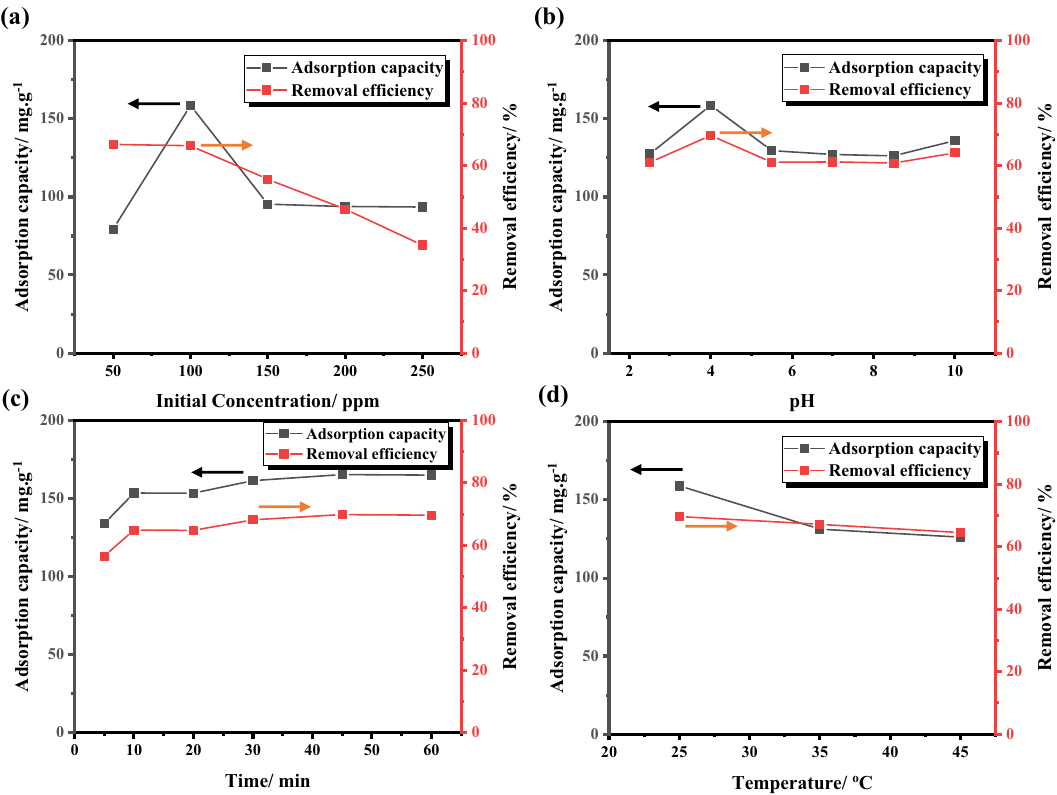
Figure 10. ( a ) Initial concentration (temperature of 25 °C, pH of 4–4.5), ( b ) pH (phenol dose of 100 mg L −1 , temperature of 25 °C), ( c ) Contact time (phenol dose of 100 mg L −1 , temperature of 25 °C, pH of 4), and ( d ) Temperature effect (phenol dose of 100 mg L −1 , pH of 4) on adsorption of phenol over SD_AC_H 2 O_900